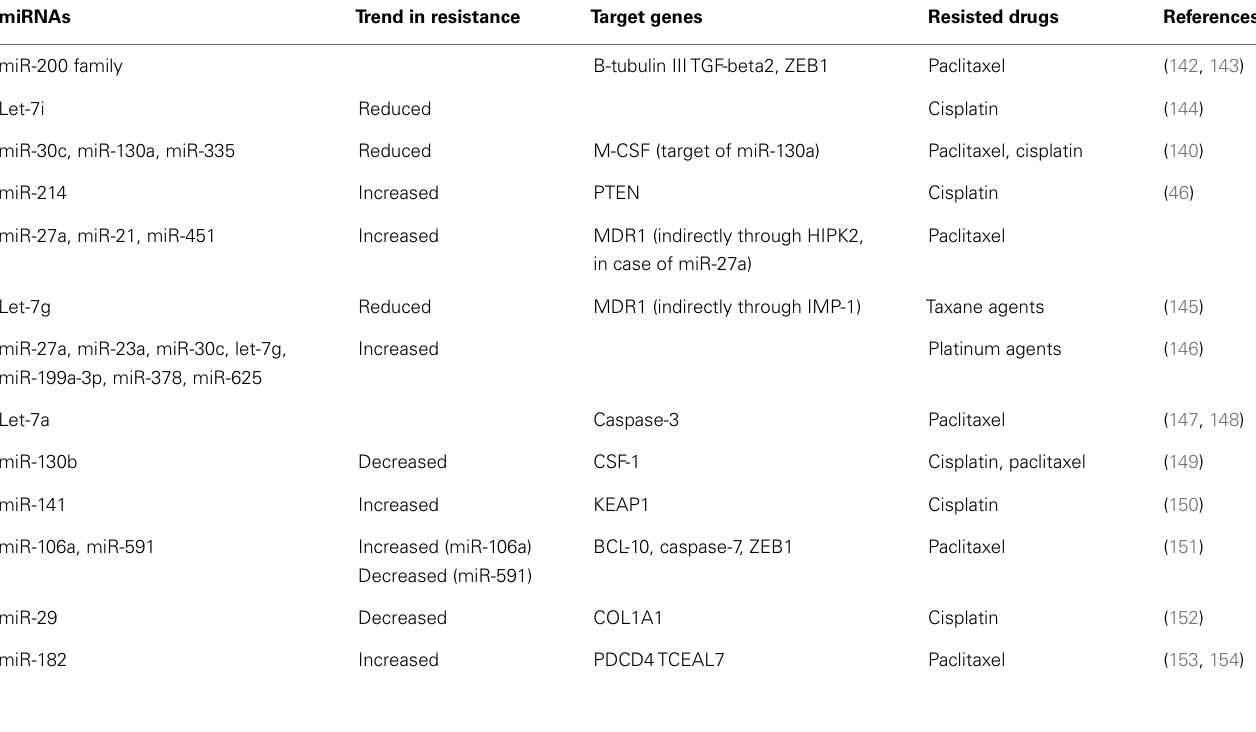
Table 3 | miRNAs involved in